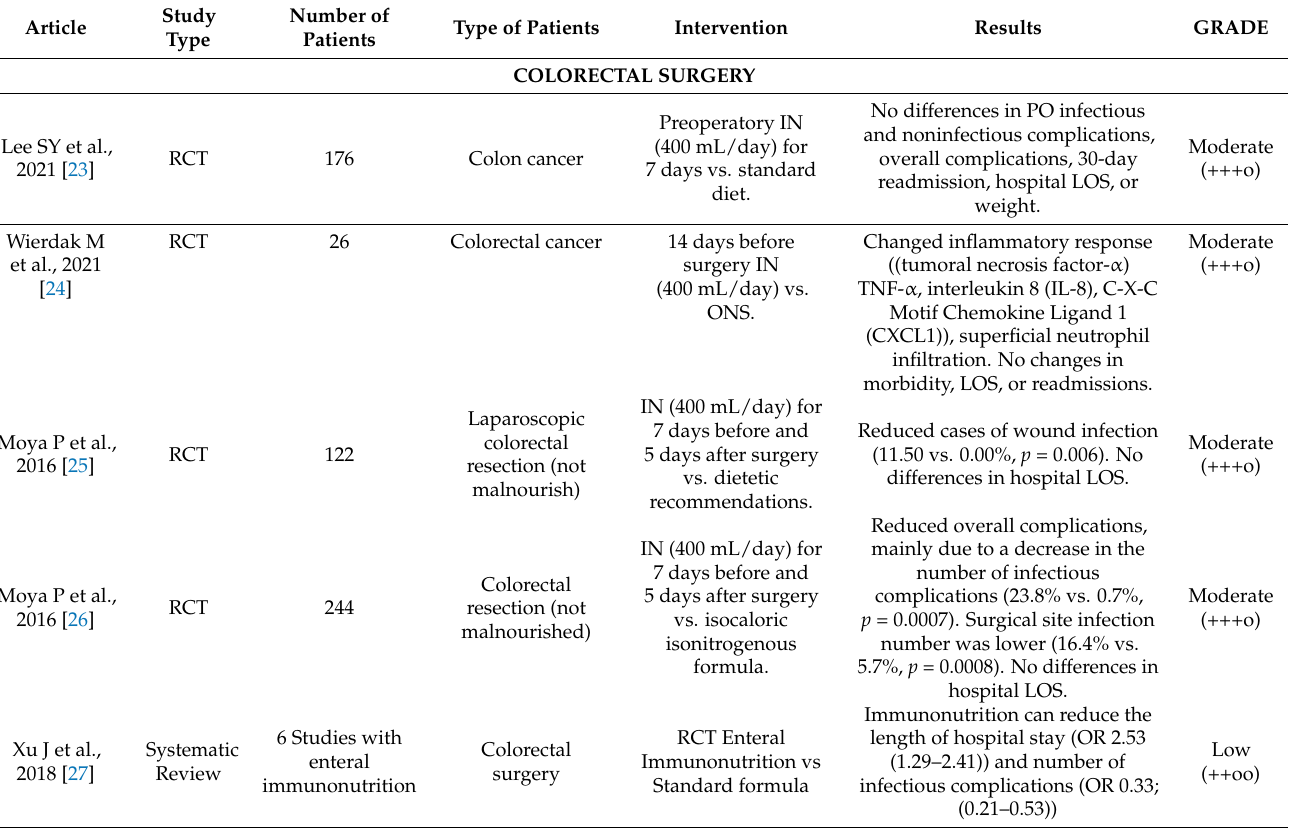
Table 6. Summary of the evidence obtained based on the search strategy and selection of articles with evidence rating using GRADEpro for colorectal surgery. IN: immunonutrition; SN: standard nutrition; ONS: oral nutrition supplement; PO: postoperative; LOS: length of